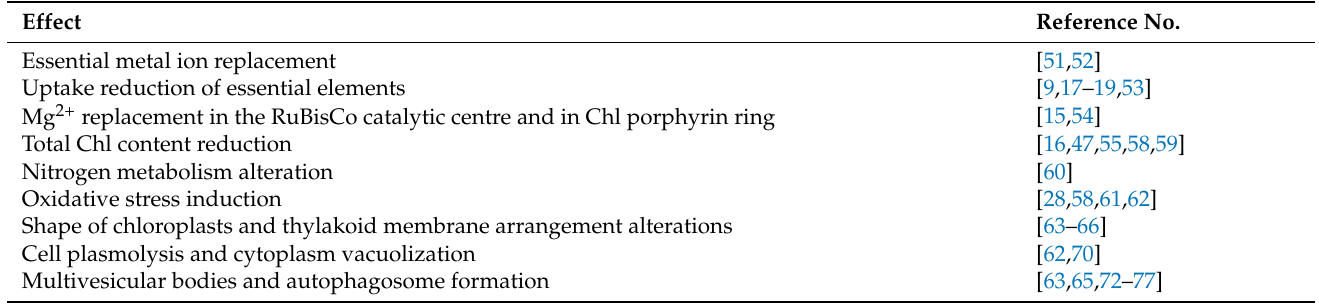
Table 1. Cd effects in charophytes and